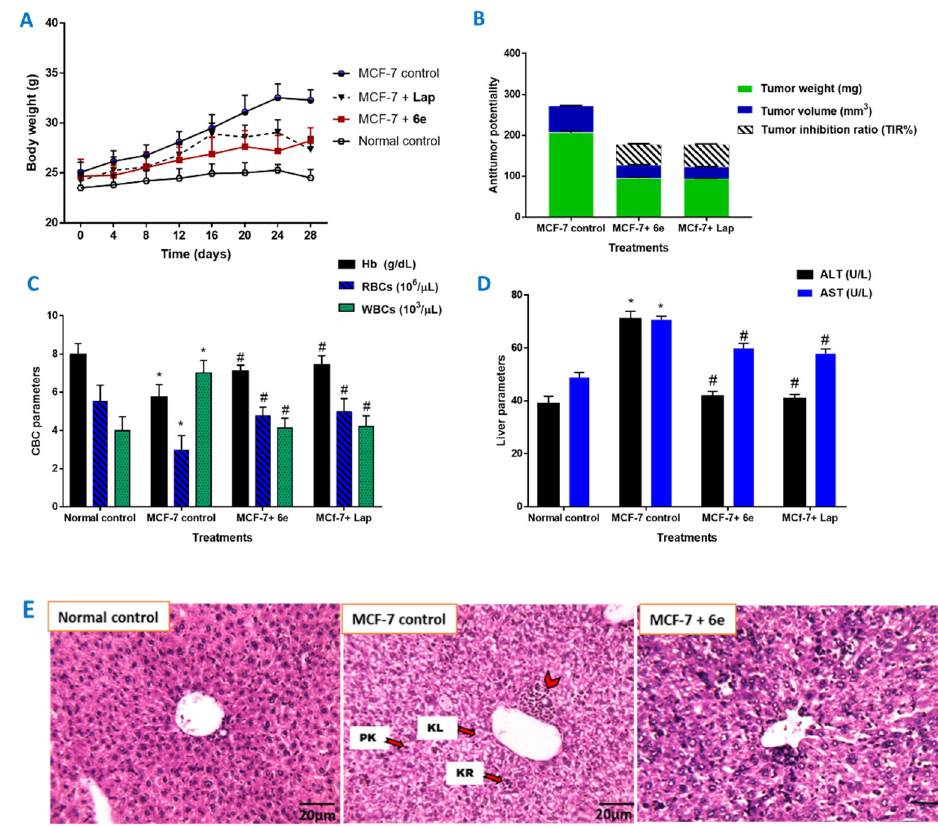
Figure 7. Assessment of in vivo results (Xenograft model) ( A ) bodyweight increase during experiment duration, ( B ) antitumor potentiality of solid mass volume, mass, and tumor inhibition ratio (TIR%), ( C ) Hematological assays of Hemoglobin, Red blood cells, and white blood cells, ( D ) biochemical assays of ALT, AST activities, and ( E ) histopathological examinations of liver tissues in different treated groups; Normal control, MCF-7 control, MCF-7 + 6e , and MCF-7 + Lapatinib. (Arrowhead) inflammatory infiltration, (KL) karyolysis, (KR) Karyorrhexis, (PK) Pyknosis. Results are expressed as mean ± SD of three independent trials. * ( p ≤ 0.05) significantly different between MCF-7 control and normal control, while # ( p ≤ 0.05) is significantly different between treated groups compared to MCF-7 control.